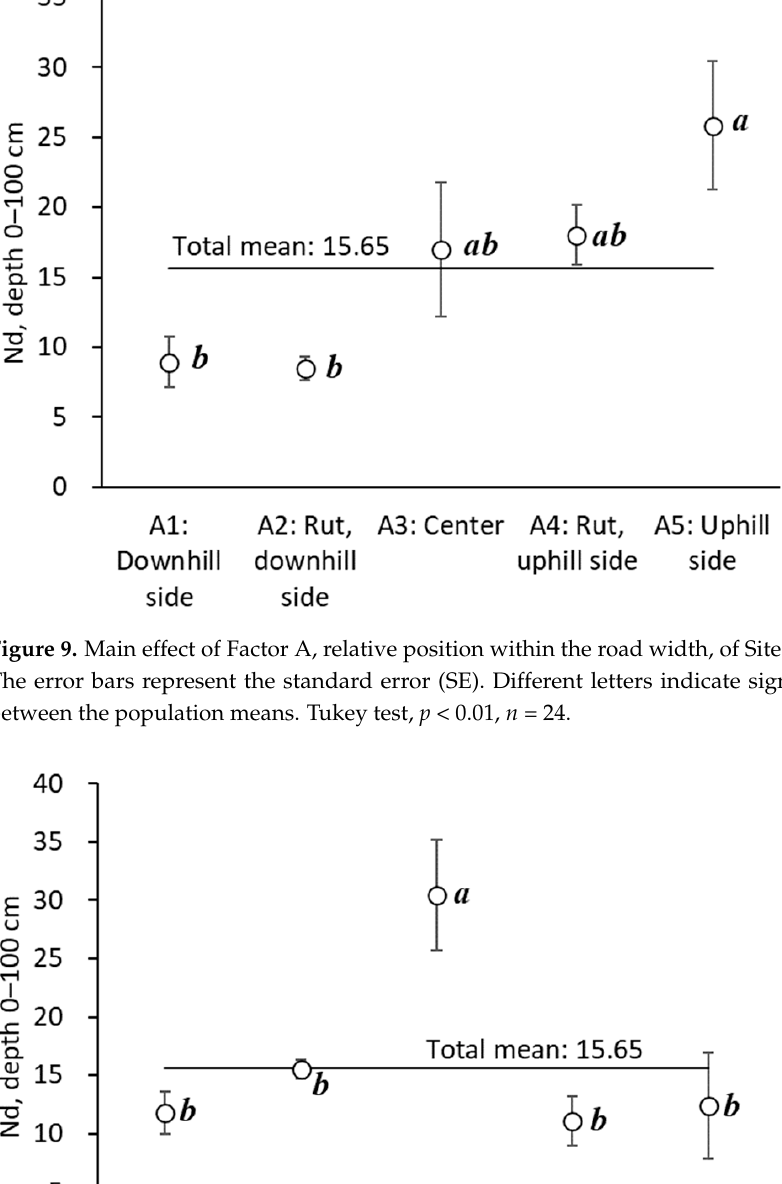
Figure 9. Main effect of Factor A, relative position within the road width, of Site 1 on the N d -value. The error bars represent the standard error (SE). Different letters indicate significant differences between the population means. Tukey test, p < 0.01, n = 24.